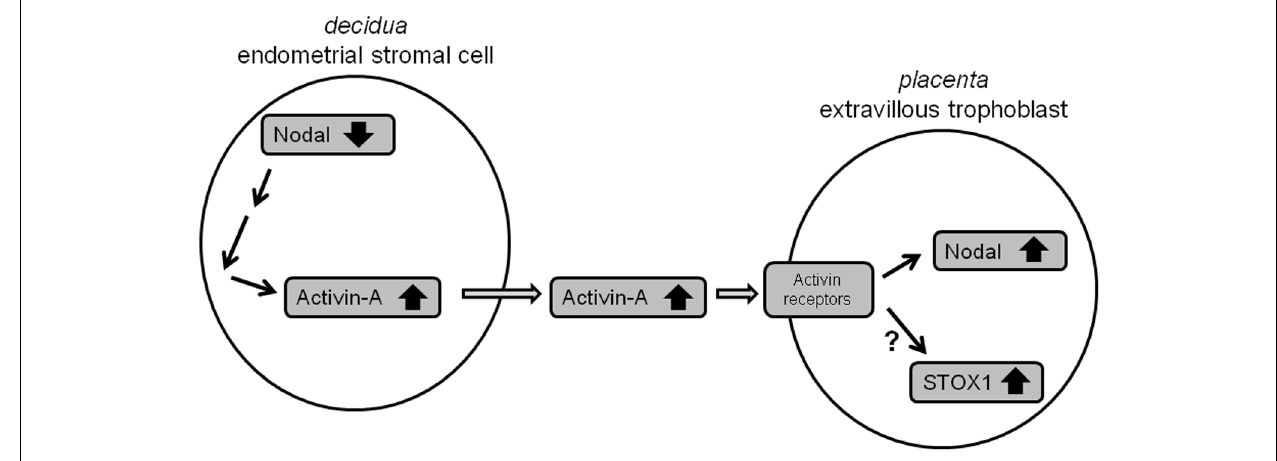
FIGURE 7 | Model of the interaction between maternal Nodal and fetal Nodal at the maternal–fetal interface. Reduced expression of Nodal in endometrial stromal cells in the decidua, for instance due to NODAL-H165R